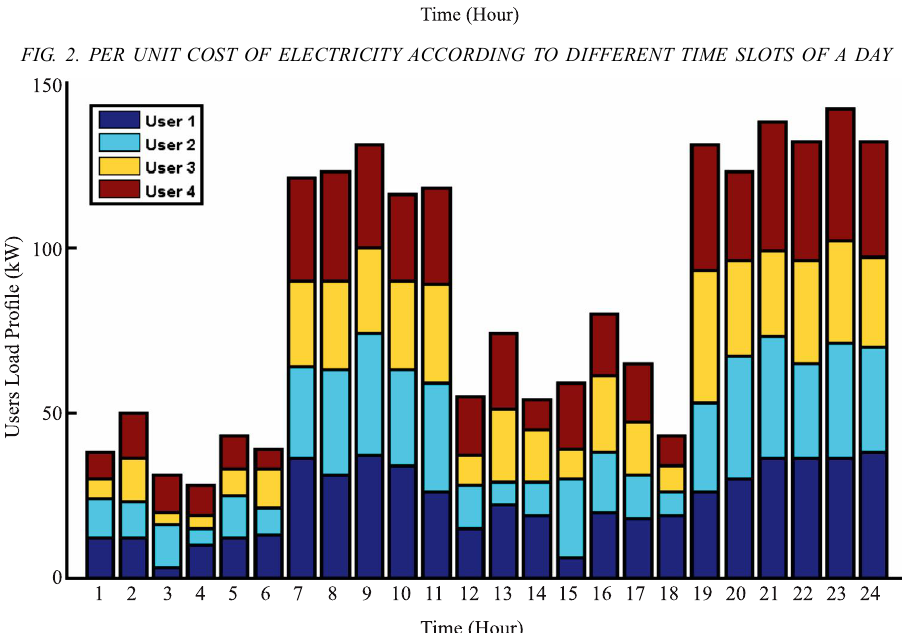
FIG. 3. PREDICTED ELECTRICITY LOAD (PL) PROFILE OF FOUR SMART HOMES USERS ACCORDING TO 24 HOURS TIME SLOTS OF A